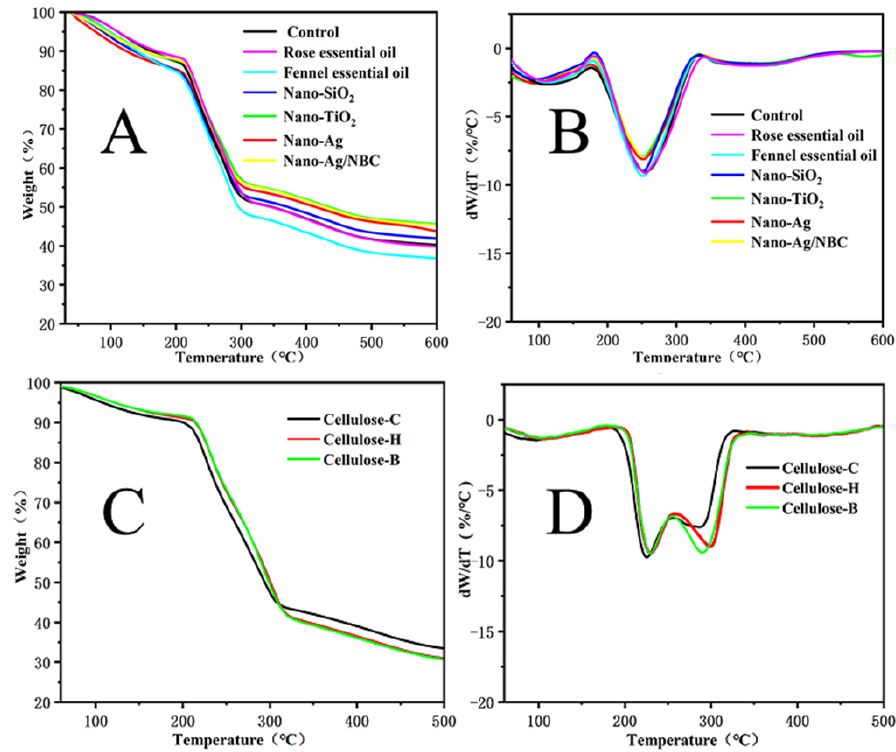
Figure 9. The pyrolysis curve of composite films (( A , B ) for TG and DTG for CMBC composite films, respectively; ( C , D ) for TG and DTG for CMC composite with nano ‐ Ag particles films, respectively). Table 3. Mechanical and physical properties of CMBC composite films